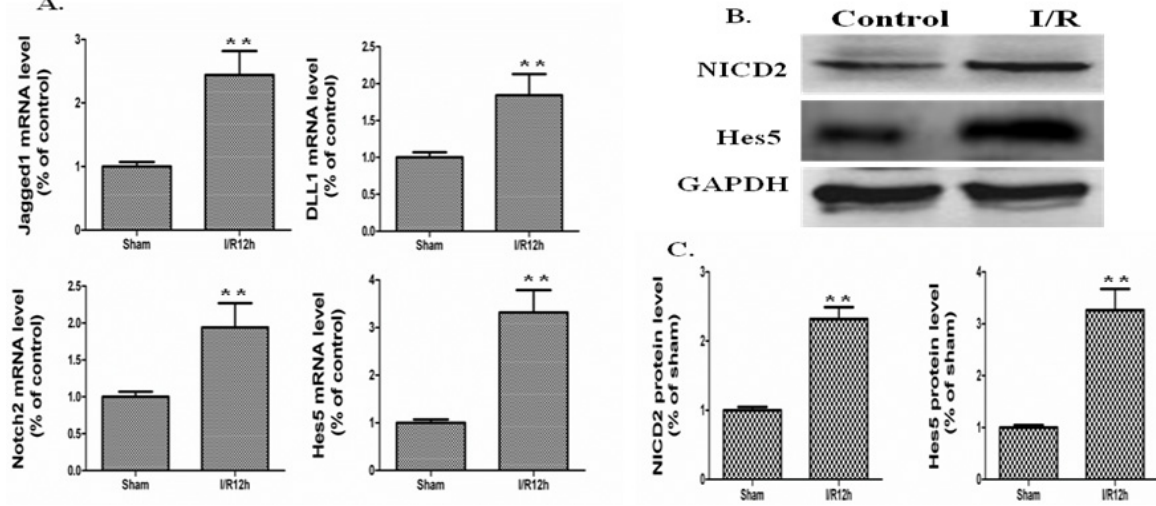
Figure 2. The transcripts and protein levels of Notch signaling components were increased in intestine after I/R injury. ( A ) The I/R and sham operated mice were sacrificed at indicated times, mRNA of intestinal mucosa was collected, and real-time PCR was performed to detect mRNA levels of Jagged1 , DLL1 , Notch2 , and Hes5 . GAPDH was used to verify equivalent loading. Data are given as the means ± SDs ( n = 7). ** p < 0.01 vs. sham group; ( B ) Western blot was performed to detect protein expression of NICD2 and Hes5 . GAPDH was used to verify equivalent loading; ( C ) Graphic representation of relative expression of NICD2 and Hes5 normalized to GAPDH. Data are given as the means ± SDs ( n = 7). ** p < 0.01 vs. sham